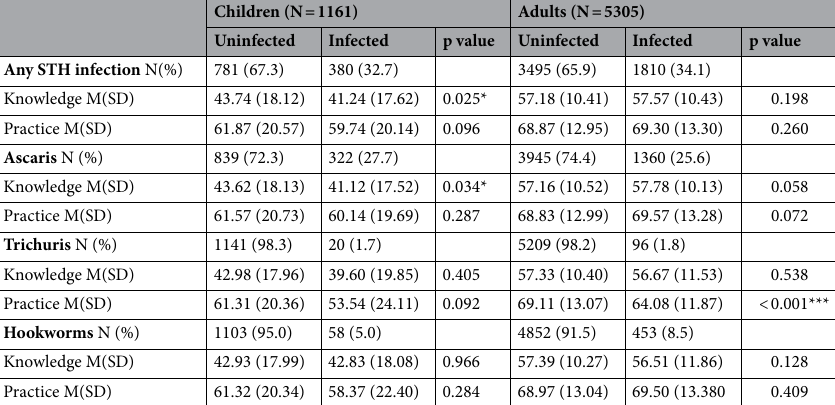
Children (N = 1161) Adults (N =